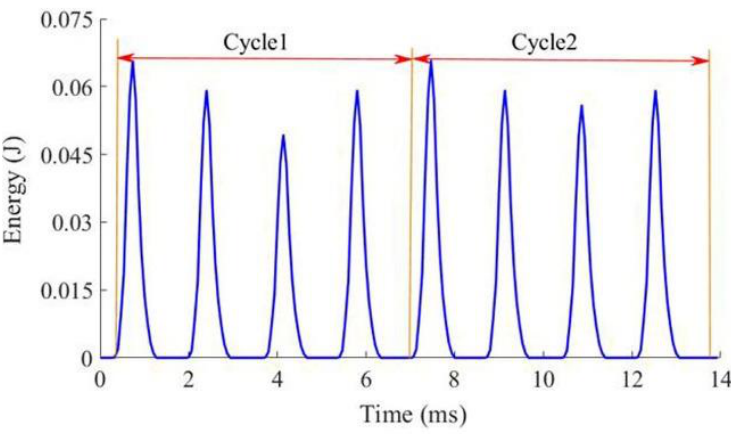
Figure 7. Periodic variation of potential energy for tooth deflection.